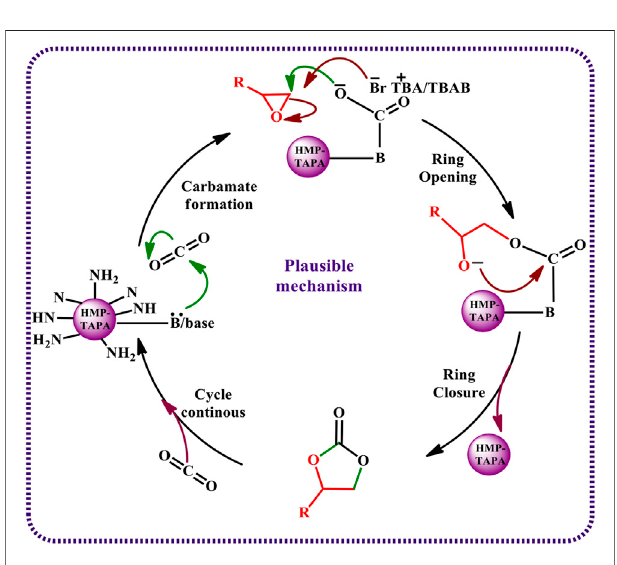
SCHEME 3 | Proposed reaction mechanism for cycloaddition of CO 2 with epoxides catalyzed by HMP-TAPA.